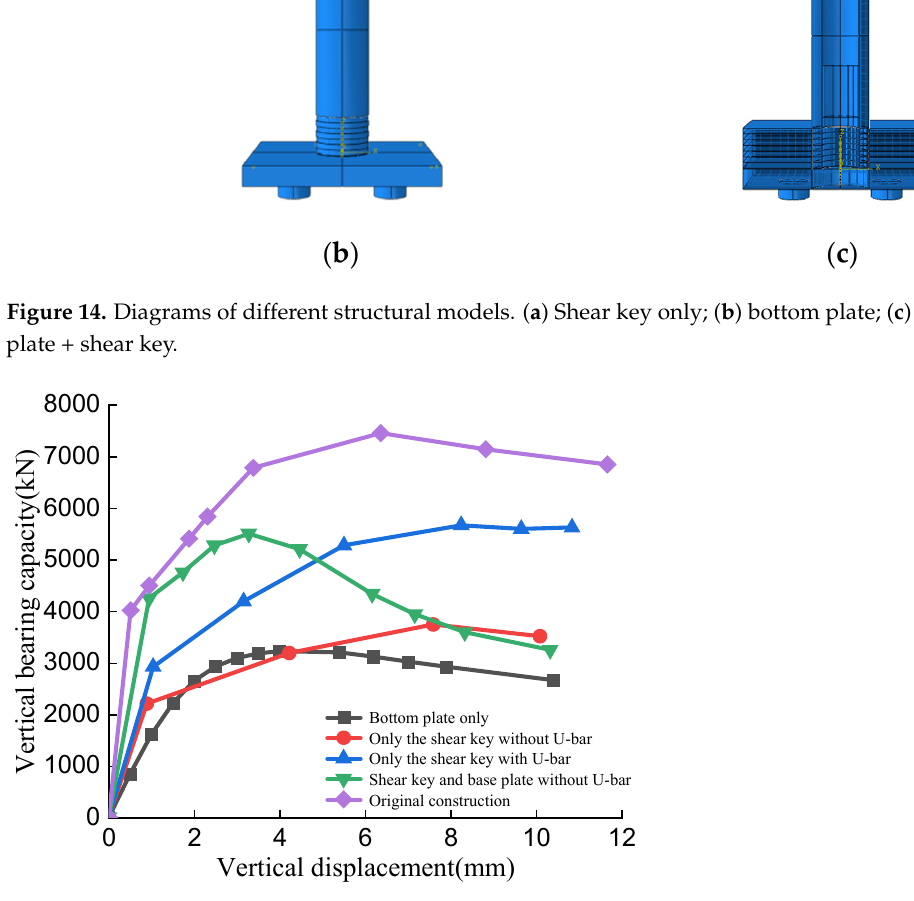
Figure 15. The contribution of different configuration measures.